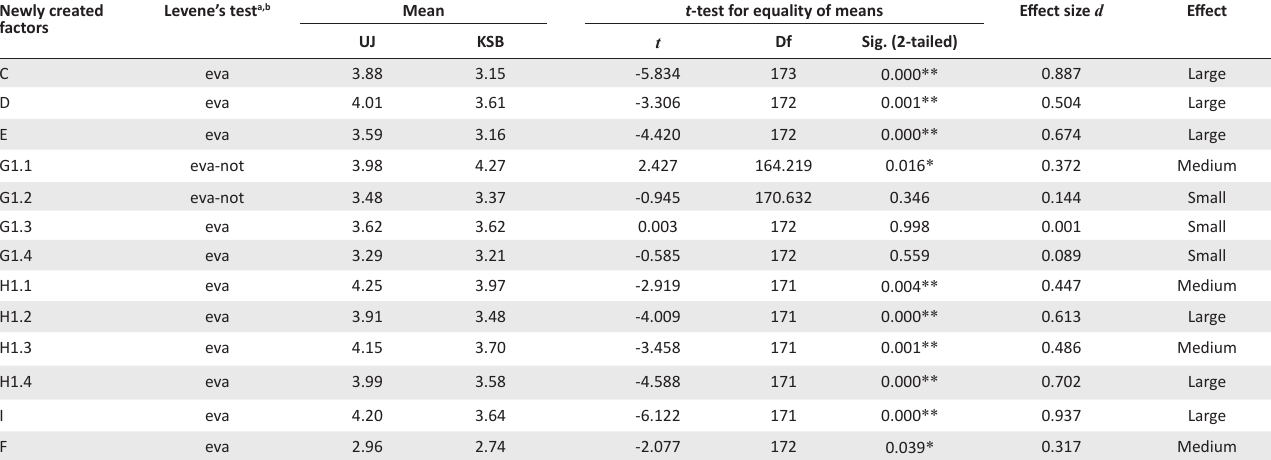
t -test for equality of